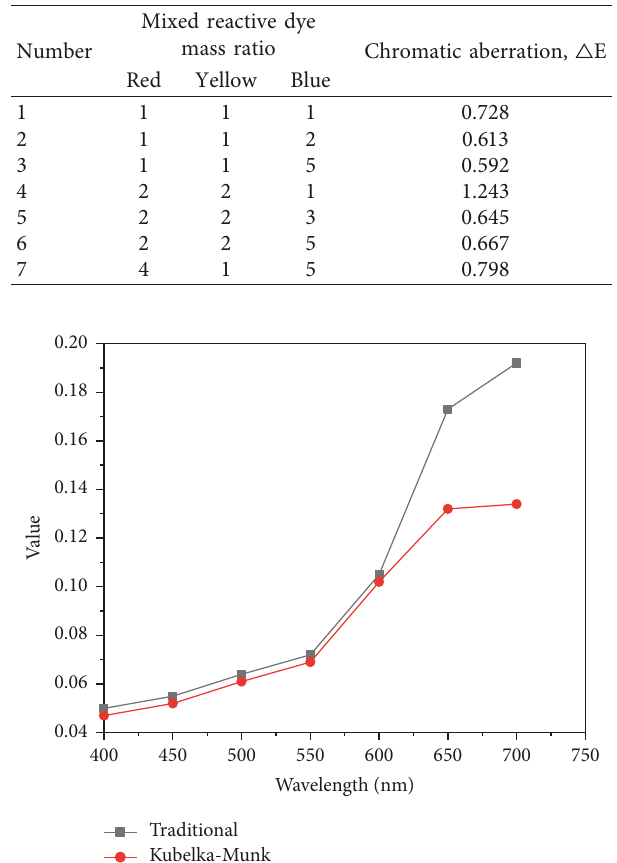
Table 2: Optimization of the Friele model based on particle swarm optimization to predict formula color